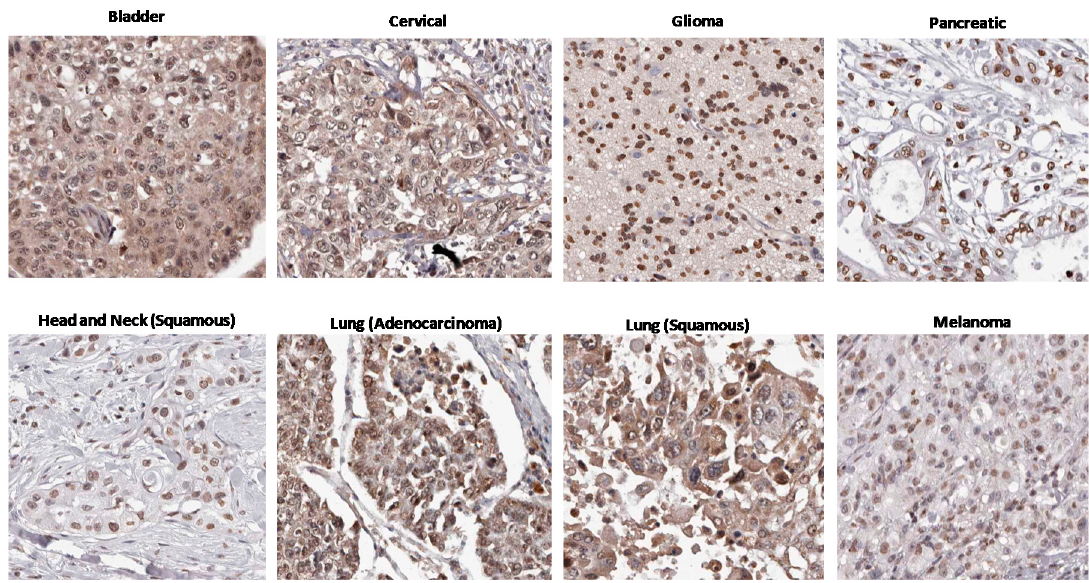
Figure 2. Nuclear AHR expression in eight human cancers. Immunohistochemistry images were obtained from the Human Protein Atlas. Nuclear staining for the AHR is evident in all eight cancer types.